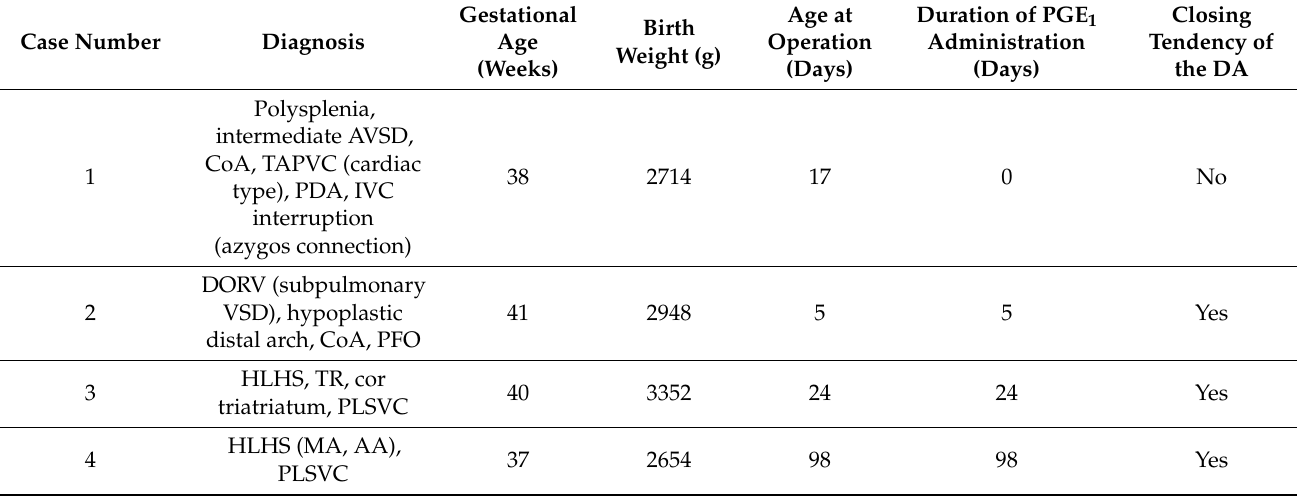
Table 1. A summary of the patient profiles for the four cases included in this